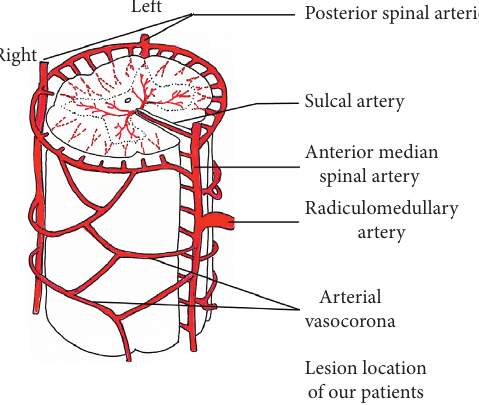
Figure 2: Schema showing the arterial supply to the cervical spinal cord (the figure is adapted from